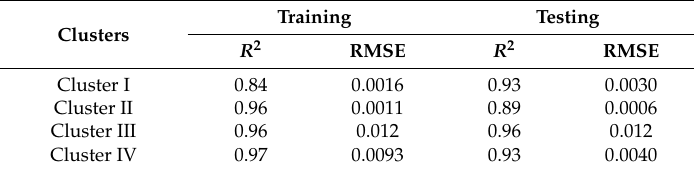
Table 3. The performance statistics of GA-BPNNs for each cluster during training and testing